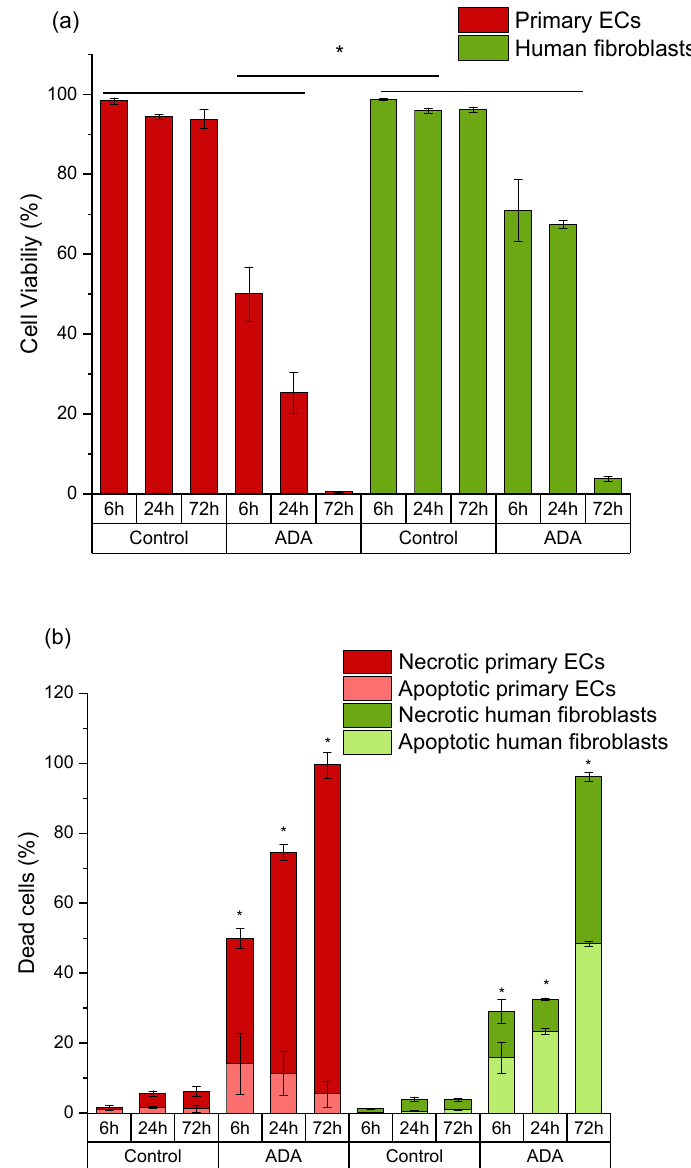
Figure 4. Time-dependent comparison of primary endothelial cells (ECs) and fibroblasts grown in ADA. ( a ) Cell viability (DiI-positive cells); ( b ) apoptotic populations in total death cluster (DiI-negative, PI-negative staining) and necrotic populations in total death cluster (DiI-negative, PI-positive staining). Control: cells with DCFH-DA grown on plastic. * p < 0.05 indicates significant differences between the groups in cell viability ( a ) and number of apoptotic cells ( b ).